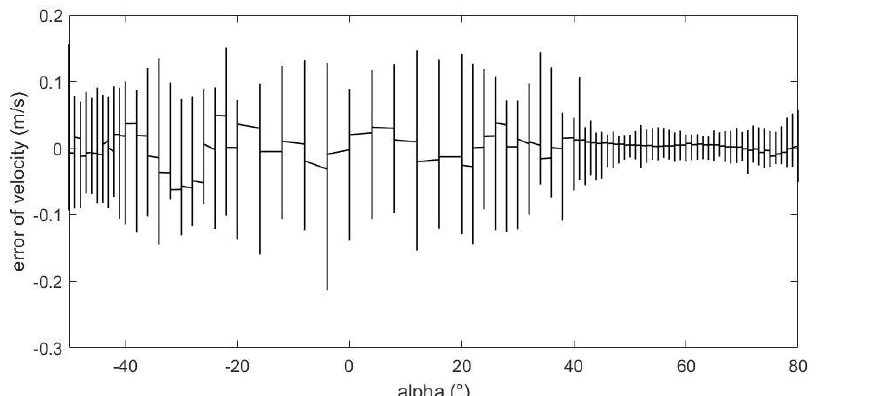
Figure 16. The relationship between velocity of incoming flow estimation error and AoA value.